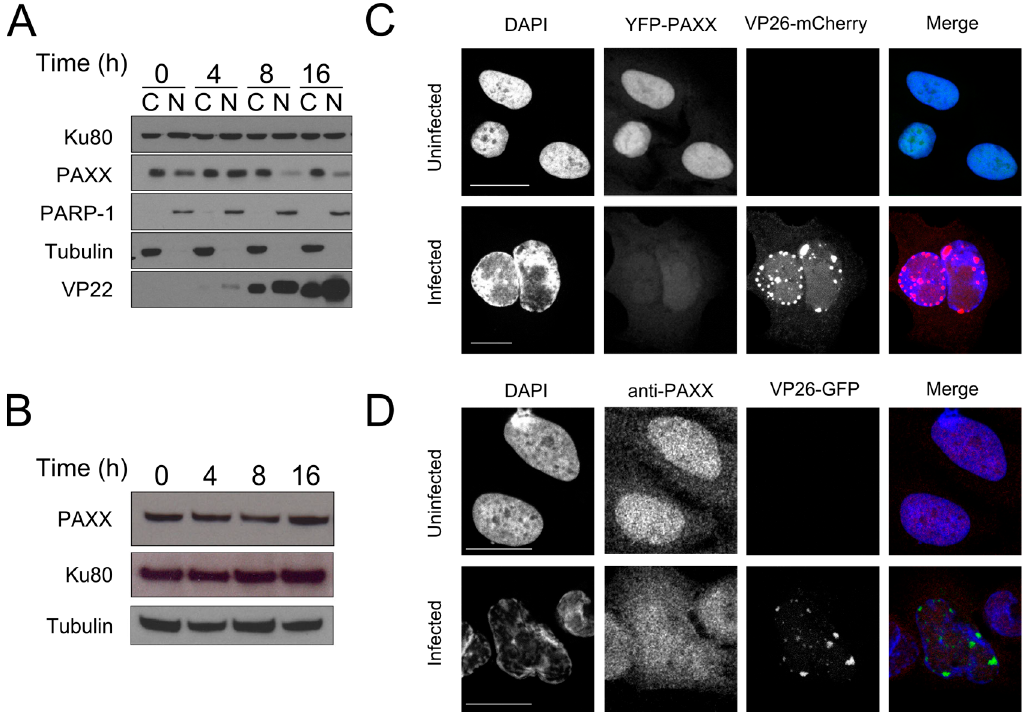
Figure 2. PAXX distribution changes during HSV-1 infection. ( A ) U2OS cells were infected at a multiplicity of infection (MOI) of 10. Cells were harvested and the cytoplasmic (C) and nuclear (N) fractions separated and probed by immunoblotting for PAXX. Poly (ADP-Ribose)-Polymerase 1 (PARP-1) and tubulin controlled for fractionation, VP22 demonstrated successful infection, and Ku80 was used as a loading control; ( B ) U2OS cells were infected at MOI 10 and whole cell lysates immunoblotted with the indicated antibodies; ( C ) Yellow fluorescent protein (YFP)-PAXX was ectopically expressed in U2OS cells, and these were infected with HSV-1 VP26-mCherry at MOI 1. 16 h after infection slides were imaged by confocal microscopy; ( D ) U2OS cells were infected with Δ gE VP26-YFP HSV-1 at an MOI of 1 for 16 h and analysed by immunofluorescence. Scale bars in ( C , D ) denote 20 μ m.